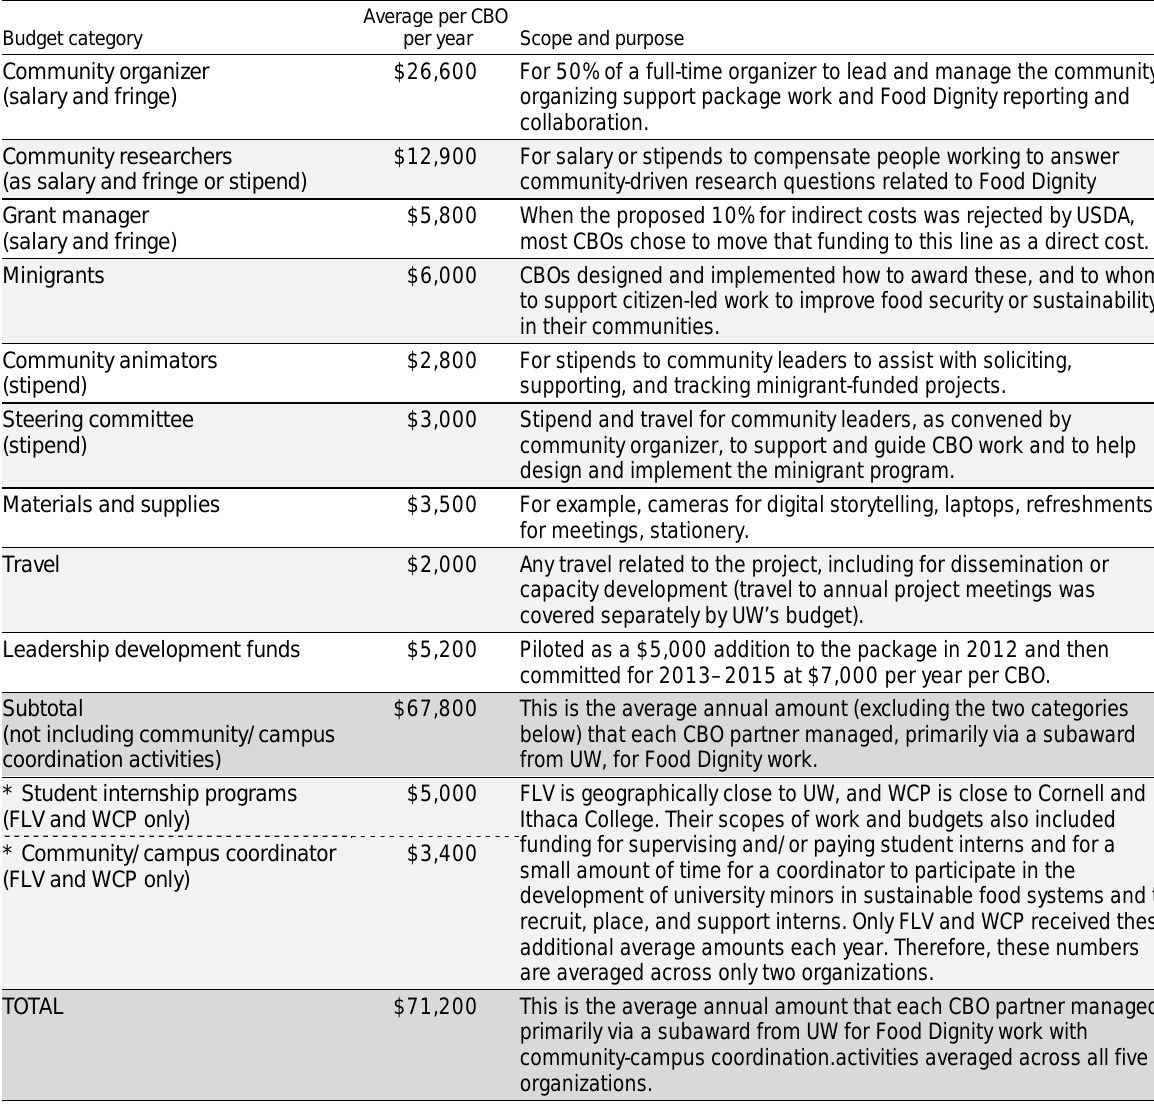
Table 1. Average Annual Community Organizing Support Package Budget for 2011 to 2016, Subawarded to Five Community Organizations a (all amounts in